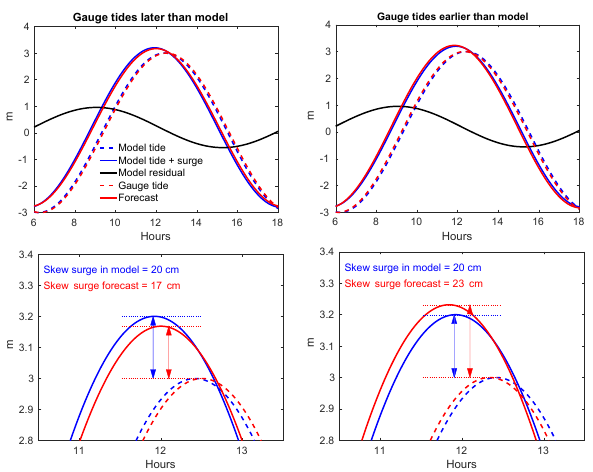
Figure 3. Suppose a surge adds a constant amplitude of 20cm and also advances the underlying 3m amplitude M 2 tide by a constant 30min. If the harmonics of the observations differ in phase by 5min from the model a forecast error of ± 3cm will result as shown. Lower panels are magnified to show high water.